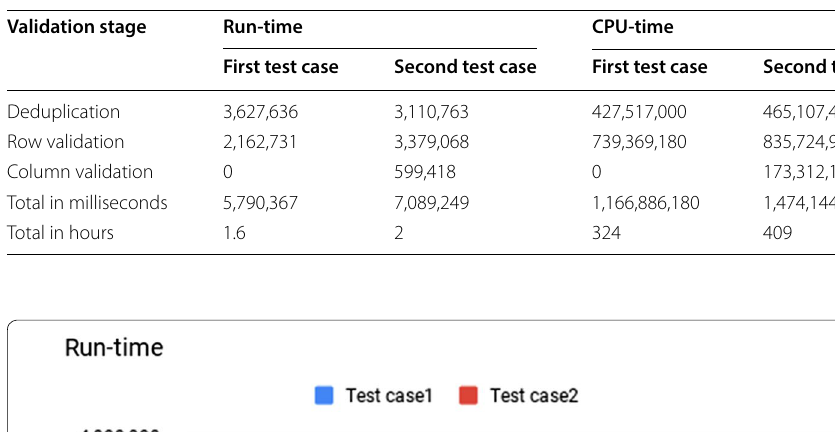
Table 12 Run-time and CPU-time for the two test cases